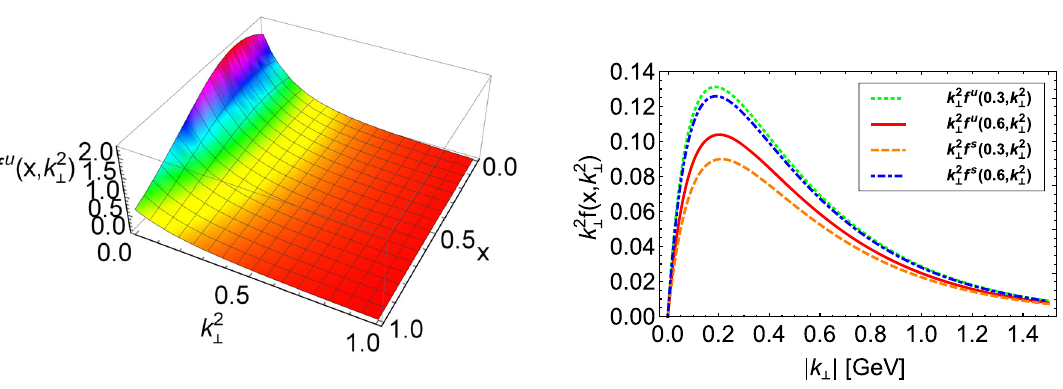
(cid:3) (cid:2) x , k 2 ⊥ for u and ¯ s quark of the kaon with different